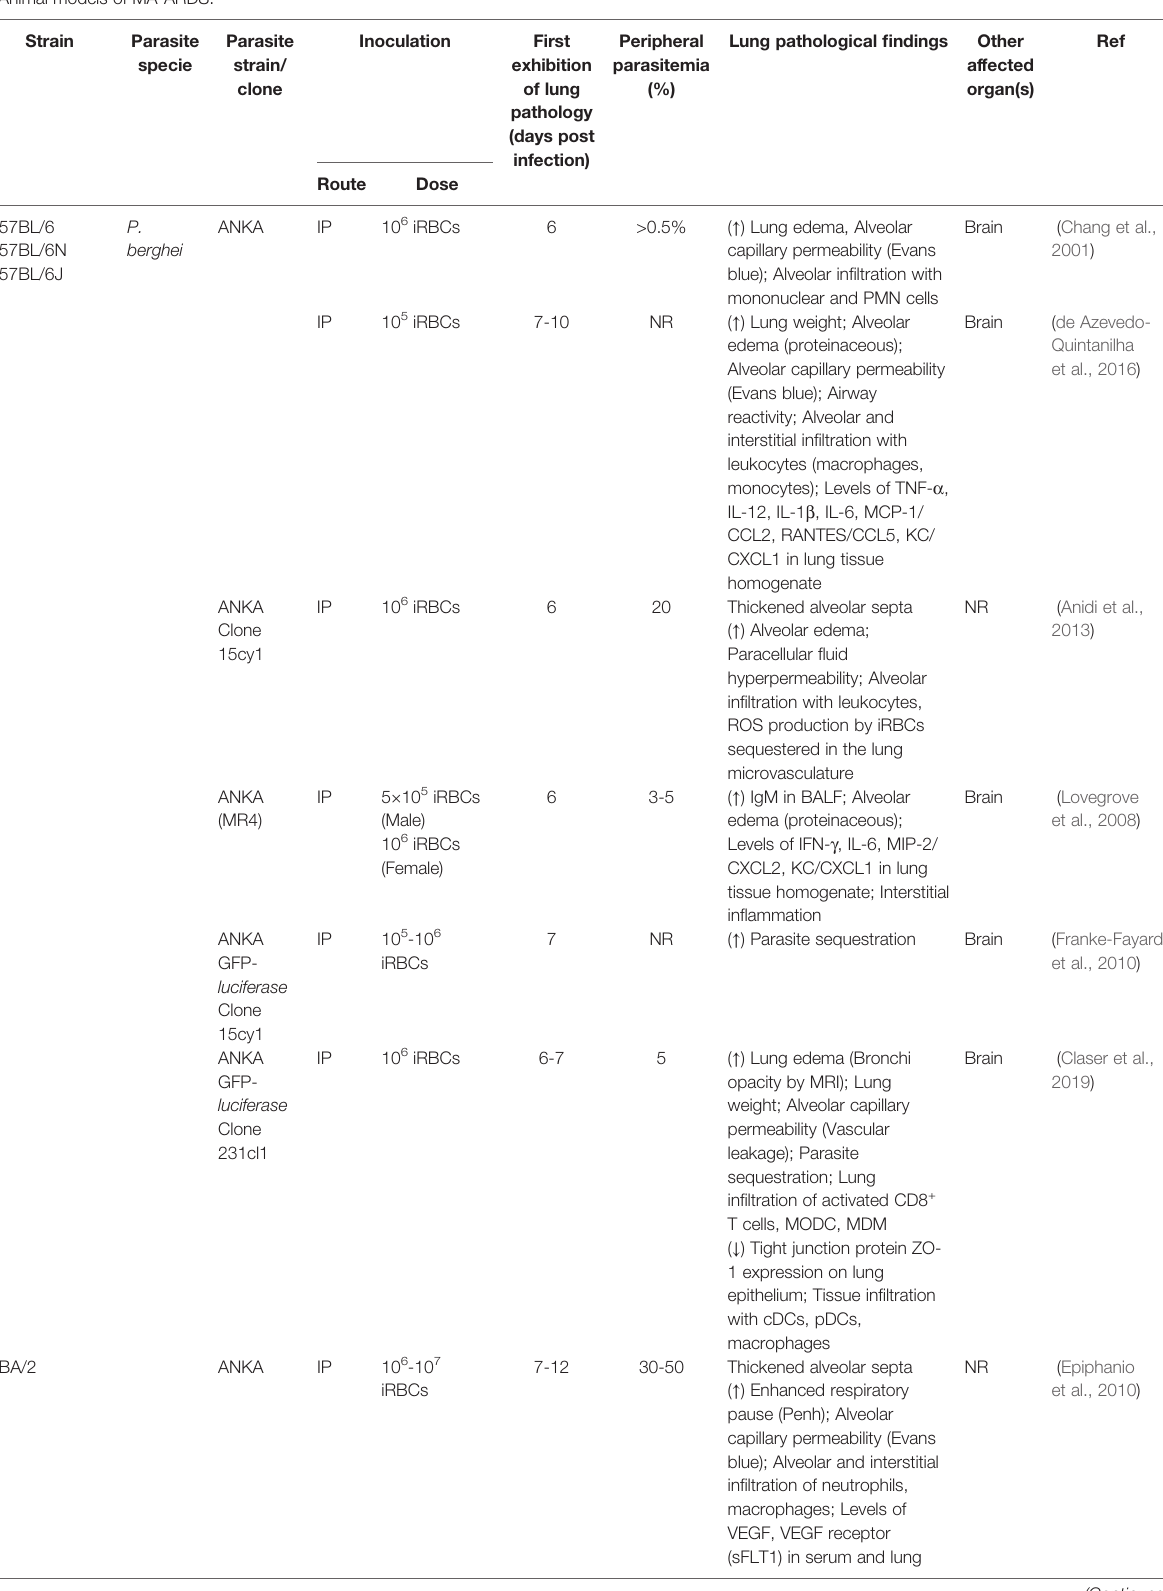
TABLE 1 | Animal models of